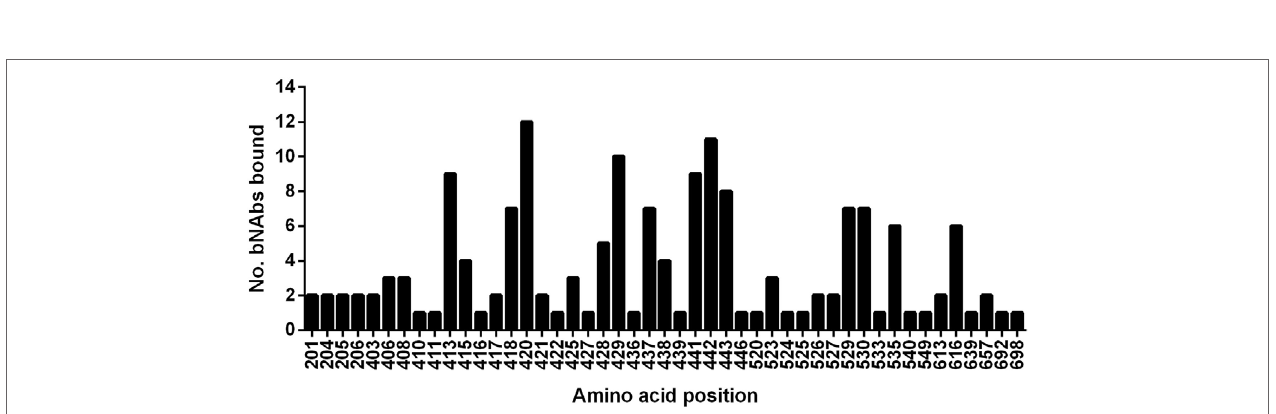
FigUre 2 | Relative usage of residues bound by broadly neutralizing antibodies. The graph plots the number of broadly neutralizing antibodies in this study that use each amino-acid as part of their epitope.